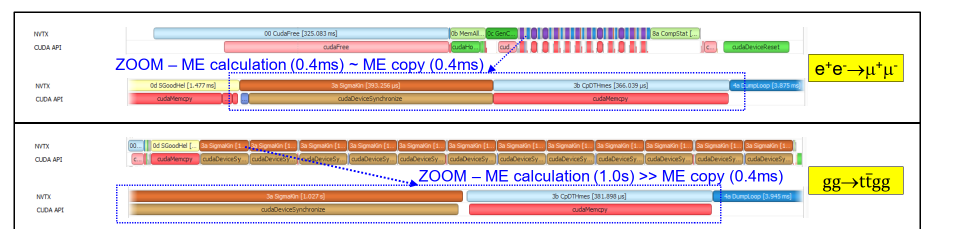
µ + µ − (top) Figure 6. Visualization of the CUDA workflow using Nvidia Nsight Systems [46], for e + e − → t ¯ t gg (bottom). Both sets of diagrams refer to the execution of the standalone executable, using and gg → 12 iterations with 524k events each (2048 blocks, 256 threads per block). The ME calculation takes µ + µ − and gg t ¯ t gg , respectively, while the ME copy takes about 0.4ms and 1.0s per iteration for e + e − → → about 0.4ms in both cases. Including both times in the computation of throughputs, this corresponds to processing rates of about 5E5 MEs / s (5E5MEs / 1.0s), and 7E8 MEs / s (5E5MEs / 0.8ms),